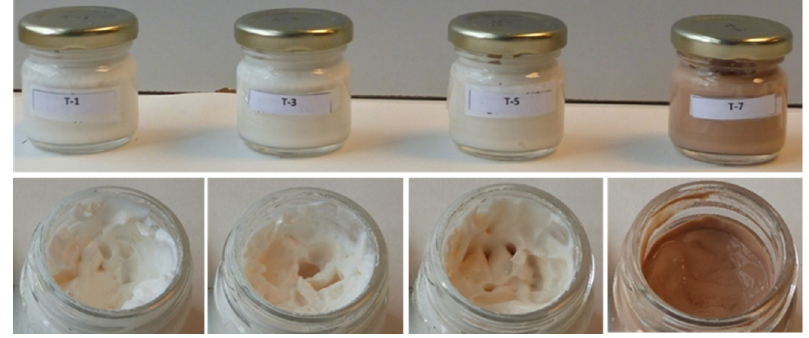
Figure 1. Suncream formulations prepared with O Tinteiro (T) water. From left to right: without extract (Bl), with α -tocopherol (TF), Fucus (FE), and Sargassum muticum (SR) extracts.